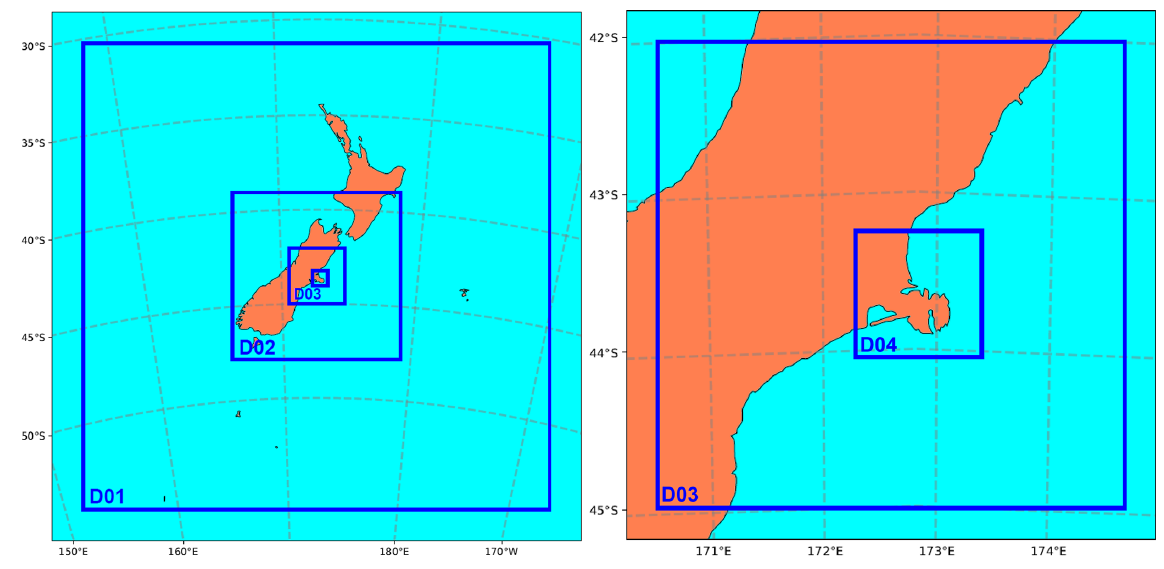
Figure 2. WRF domains configuration. Domains D01, D02, D03, and D04 with grid spacing of 27, 9, 3, and 1km respectively (contains imagery © Cartopy).